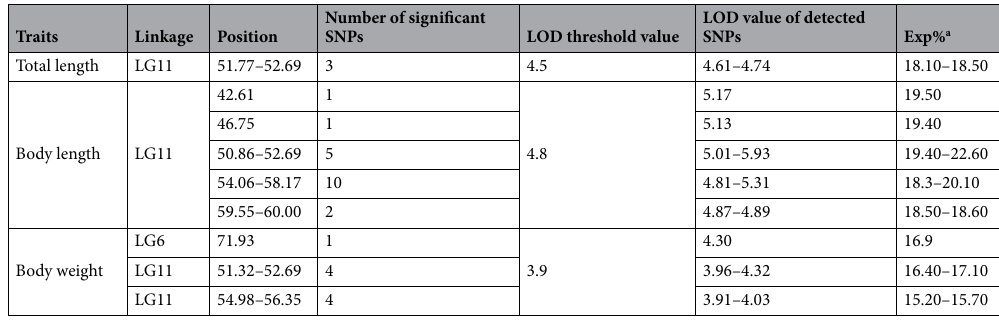
Table 4. Detected QTLs for growth-related traits of L. polyactis. a percentage of explained phenotypic